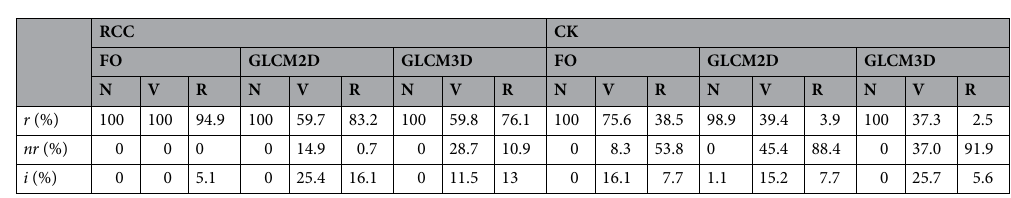
Table 4. Feature robustness against image perturbations referred to Fig.